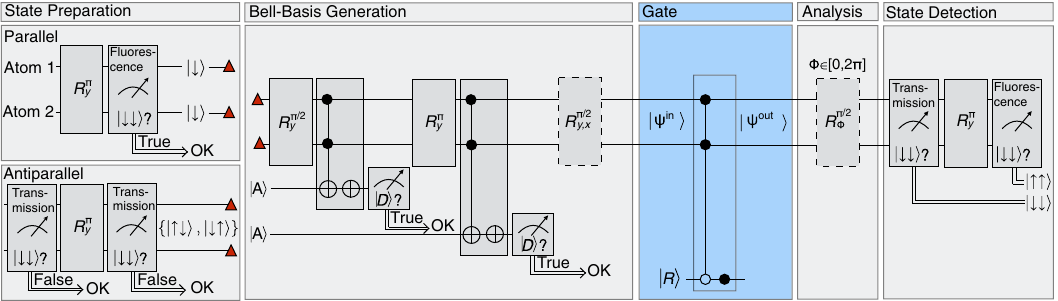
FIG. 4. Complete quantum circuit diagram depicting initialization, preparation of Bell basis states, the two-atom gate, analysis state rotation, and final state detection. Rotations ( R ) have a subscript indicating the rotation axis x ( j ↑ i þ j ↓ i ) or y ( j ↑ i þ i j ↓ i ) and a superscript denoting the rotation angle. The two techniques for state detection are labeled transmission and fluorescence, respectively. Whenever the result of an atomic state detection or a photon polarization measurement does not yield the desired result (OK), the protocol is restarted from the beginning. Initialization with parallel states allows us to prepare the triplet Bell states j Ψ þ i and j Φ (cid:3) i as gate input. The singlet state j Ψ − i is prepared after initialization with an incoherent mixture of antiparallel states described by a density ↑↓ ih ↑↓ j þ j ↓↑ ih ↓↑ jÞ . The photon reflection with an antidiagonal ( j A i ) polarization realizes a Toffoli gate with an inversion matrix 1 2 ðj of the photonic qubit. Experimentally, this means that the polarization of the reflected photon is flipped to j D i in all cases except the one where both atoms occupy j ↓ i . The dashed box in the Bell basis generation section is optional and needed only when transforming j Ψ þ i to j Φ (cid:3) i . Various two-atom states j Ψ in i are prepared as gate input, then processed by the two-atom gate, and the result j Ψ out i is characterized by state detection in a two-atom basis set by a preceding analysis rotation. The dashed box in the analysis section is ~ P optional. For a measurement of the populations P it is omitted while for a measurement of the populations , with i; j ∈ f ↓ ; ↑ g , it i;j i;j is